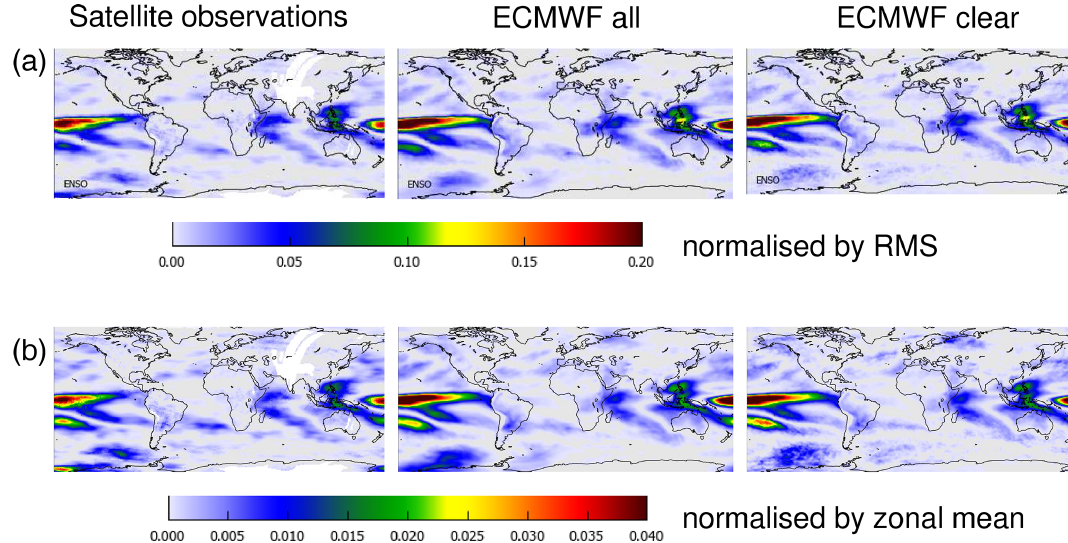
Figure A1. Comparison of delta rms values for the ENSO index calculated in two different ways. (a) The difference of the rms with and without the ENSO index included in the fit is divided by the respective rms of each 1 ◦ × 1 ◦ pixel; (b) the difference of the rms with and without the ENSO index included in the fit is divided by the zonal mean of the TCWV at the same latitude. Note the different colour scales.